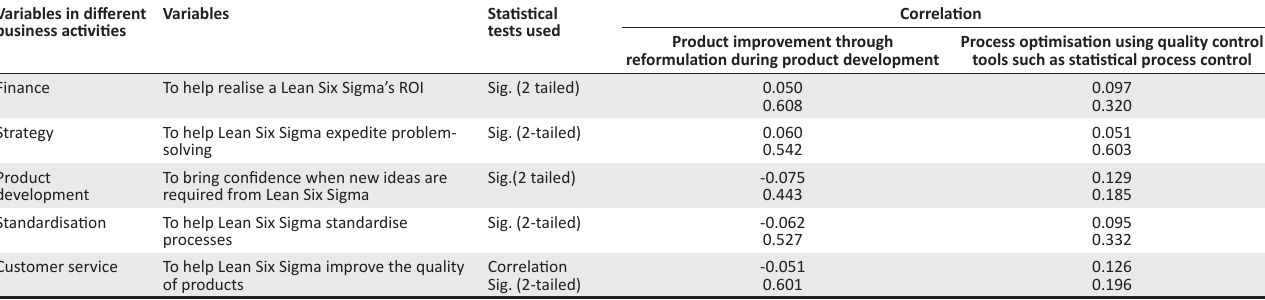
TABLE 1: The appropriateness of Design of Experiments to support Lean Six Sigma and product improvement through reformulation during product development. Variables in different business